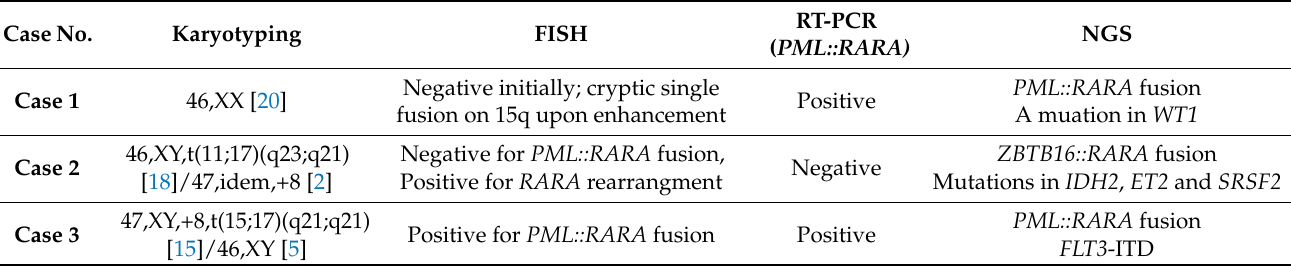
Table 1. Summary of genetic testing utilized in all three